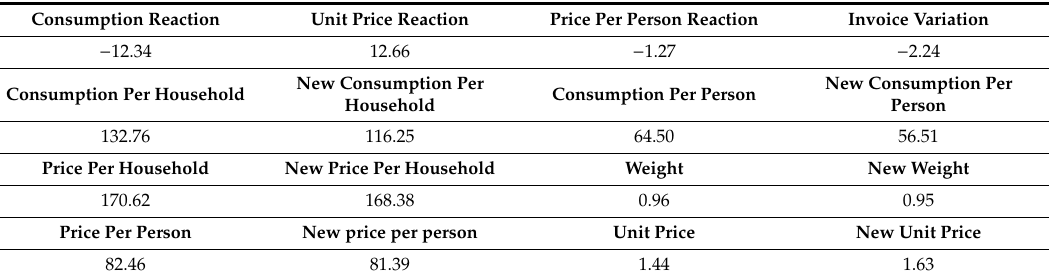
Table 7. Summary for